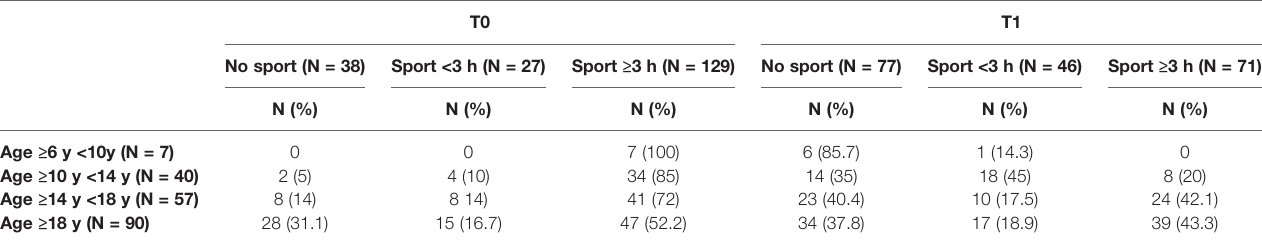
TABLE 4 | Study population divided by age and by sport group at T0 and T1 (N = 194). T0 T1